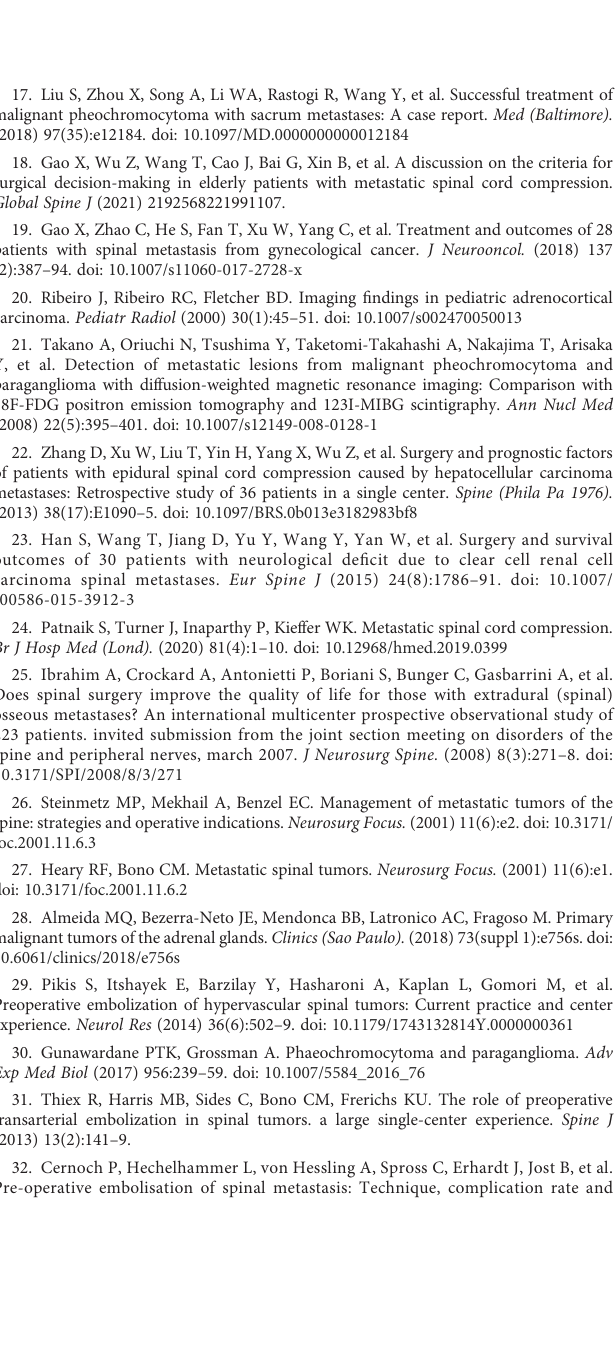
SUPPLEMENTARY FIGURE 1 (A – C) Preoperative sagittal and transverse MRI images of L1-L2 vertebral body tumors; (D, E) Preoperative transverse CT scan showed L1-L2 vertebral body tumors; (F, G) She had a history of adrenal tumor (4 points). Visceral metastases were detectable (2 points). Bone metastases were multiple (2 points). Her total prognostic score was 8 points. So, we chose the surgical strategy of subtotal resection. The tumor was excised by subtotal resection, pedicle screws, bone cement and titanium rods were used to reconstruct the stability; (H, I) Postoperative X-ray. SUPPLEMENTARY FIGURE 2 (A – C) Preoperative sagittal, coronal, and transverse MRI images of T3 vertebral body tumors; (D) Preoperative transverse CT scan showed T3 vertebral body tumors; (E, F) He had a history of adrenal tumor (4 points). Visceral metastases were not detectable (0 point). Bone metastases were isolated (1 point). His total